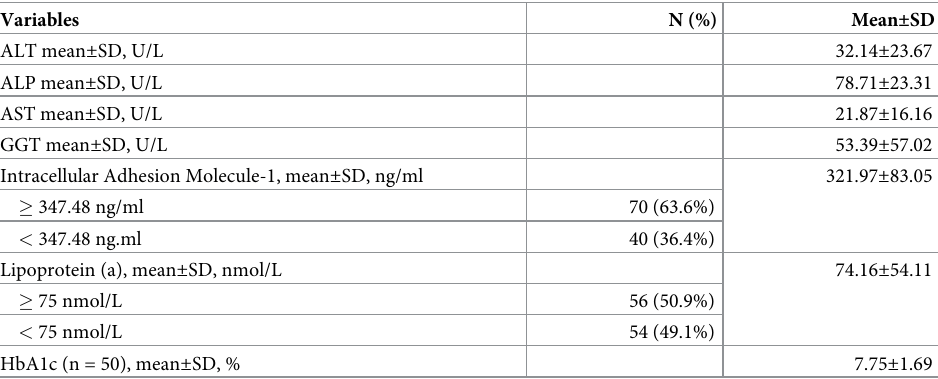
Table 2. Mean CIMT was higher in the NAFLD group compared to the non-NAFLD group (0.80 ± 0.30 vs 0.60 ± 0.10 mm, p = 0.001). The clinically significant abnormal CIMT of >